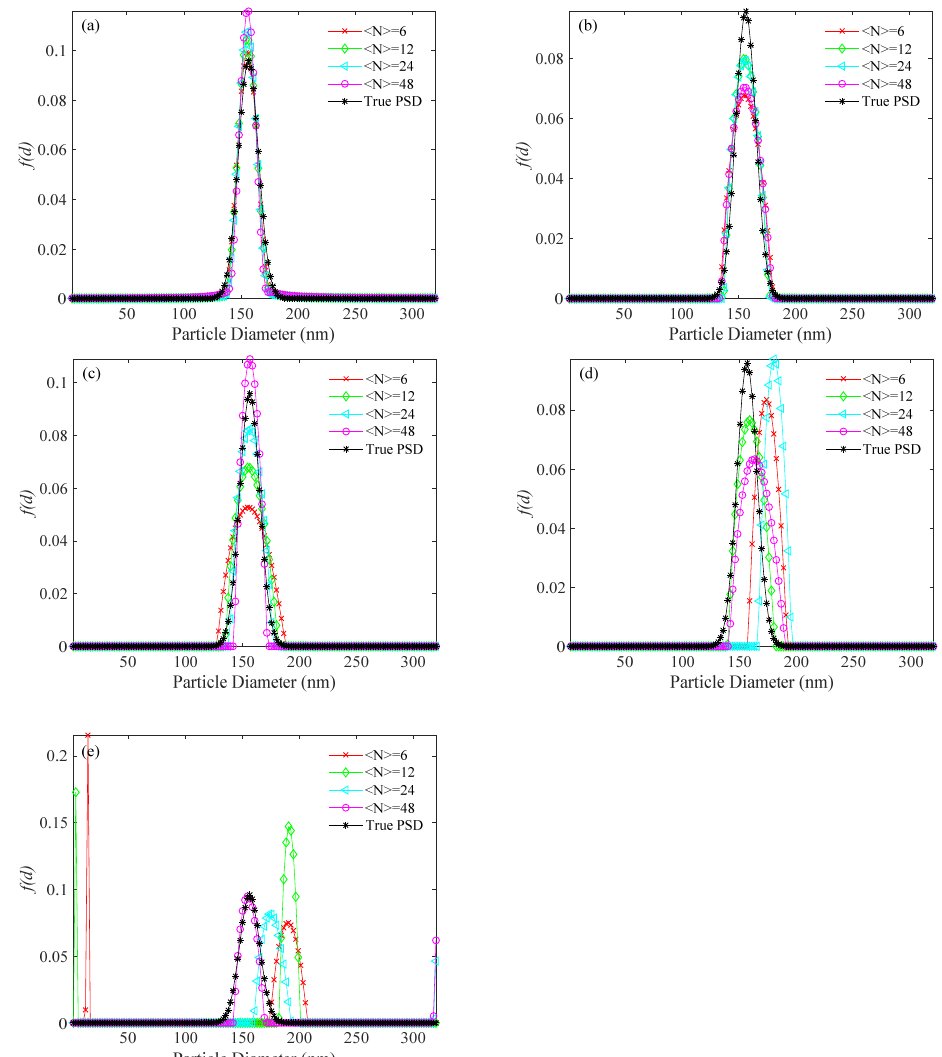
Figure 4. PSD recovered by the usual method for a 156 nm unimodal sample at number concentrations of < N > = 6, 12, 24, 48, and different levels of noise. ( a ) 0, ( b ) 10 − 4 , ( c ) 10 − 3 , ( d ) 10 − 2 , and ( e ) 10 − 1 noise levels.